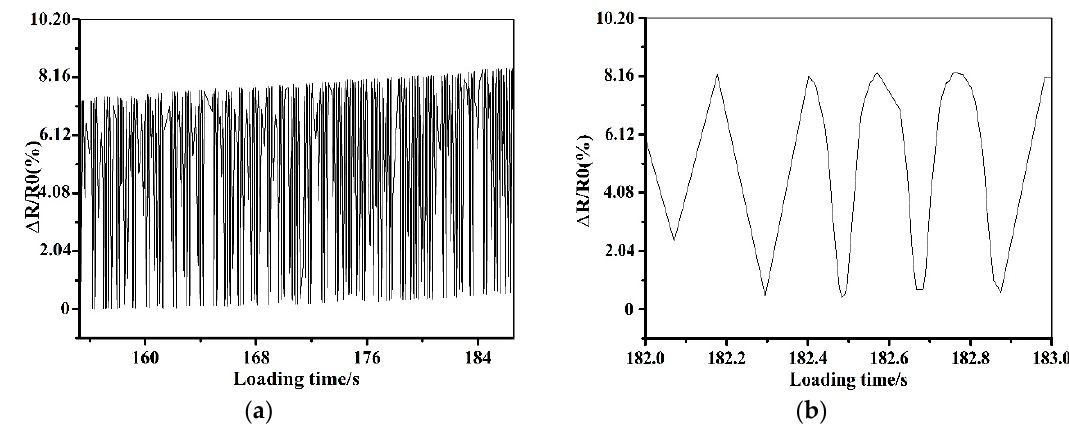
Figure 10. Resistance change of the MWCNT sensor during fatigue. ( a ) Resistance–loading time. ( b ) The enlarged drawing curves.